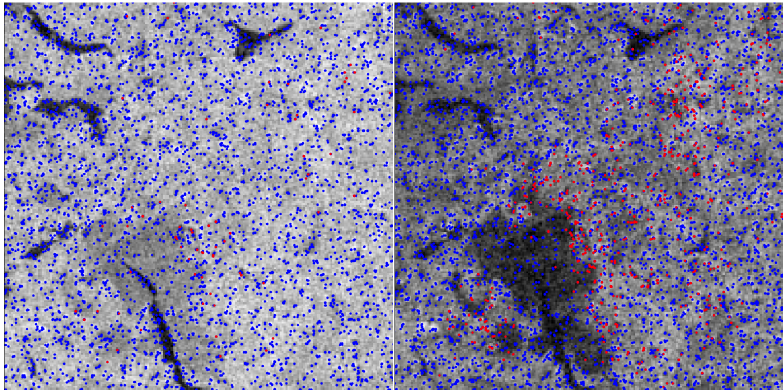
Figure 6. Identified keypoints (blue) and matched features (red) on a 200 × 200 pixels sub-image from the pack ice area in image pair Fram Strait (Table 1). Results of HH are shown in the left panel and HV in the right panel.